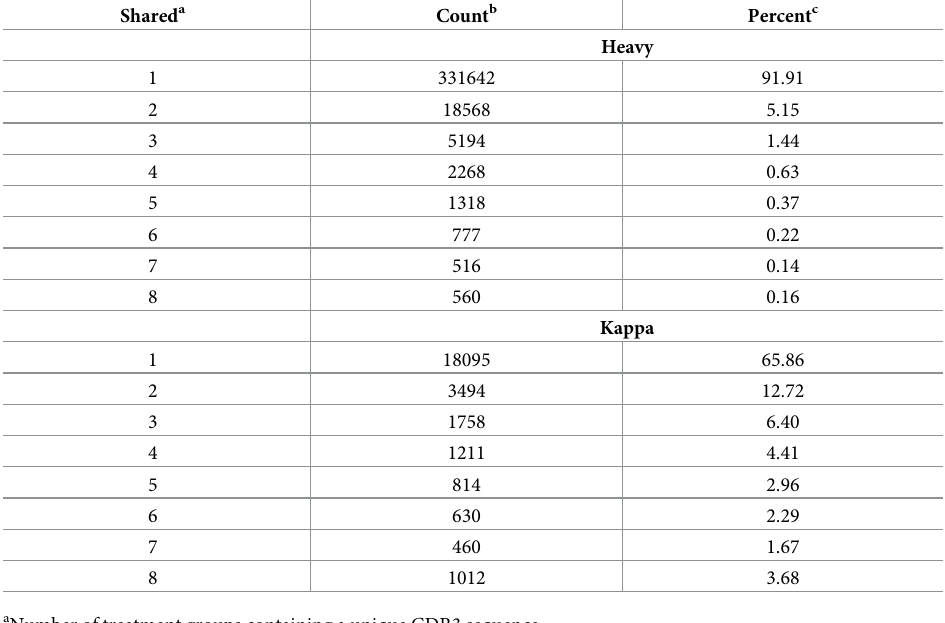
a Number of treatment groups containing a unique CDR3 sequence b Number of unique CDR3 sequences in each shared pool